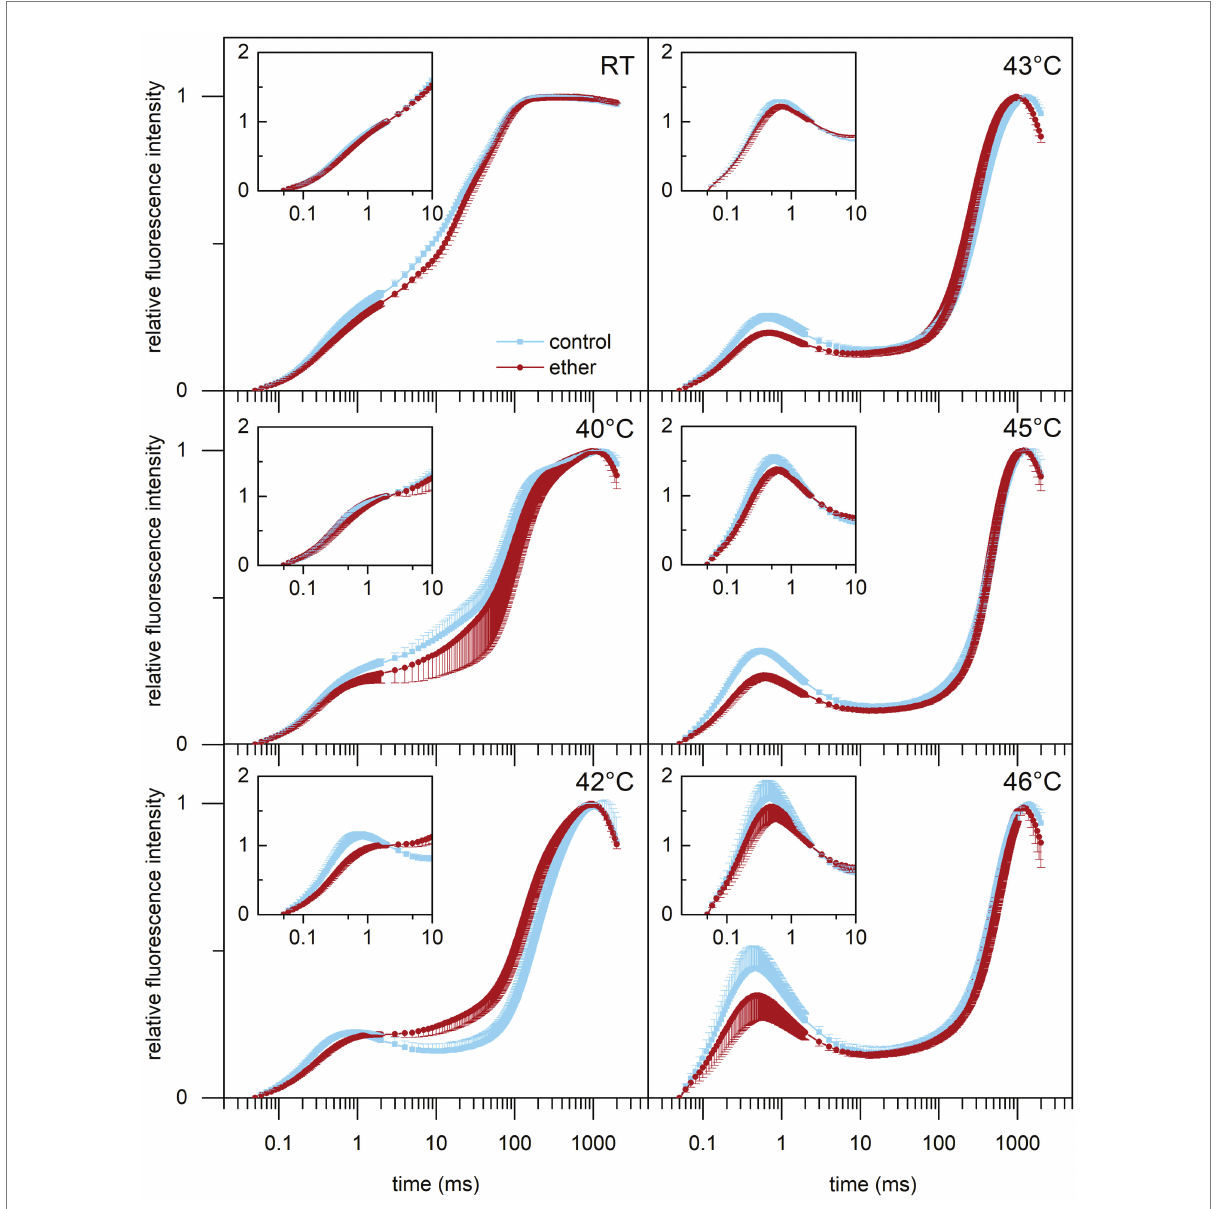
FIGURE 8 Effect of high-temperature treatment on chlorophyll a fluorescence induction transient in leaves of control and diethyl ether pre-treated Arabidopsis thaliana plants. Detached leaves were incubated for 5 min in a water bath of given temperature in darkness. RT, room temperature. The transients are normalized to variable fluorescence (F V = F M – F 0 ) or to variable fluorescence at 2 ms [F V(2ms) = F (2ms) – F 0 ; inlets]. Means ± SD, n =